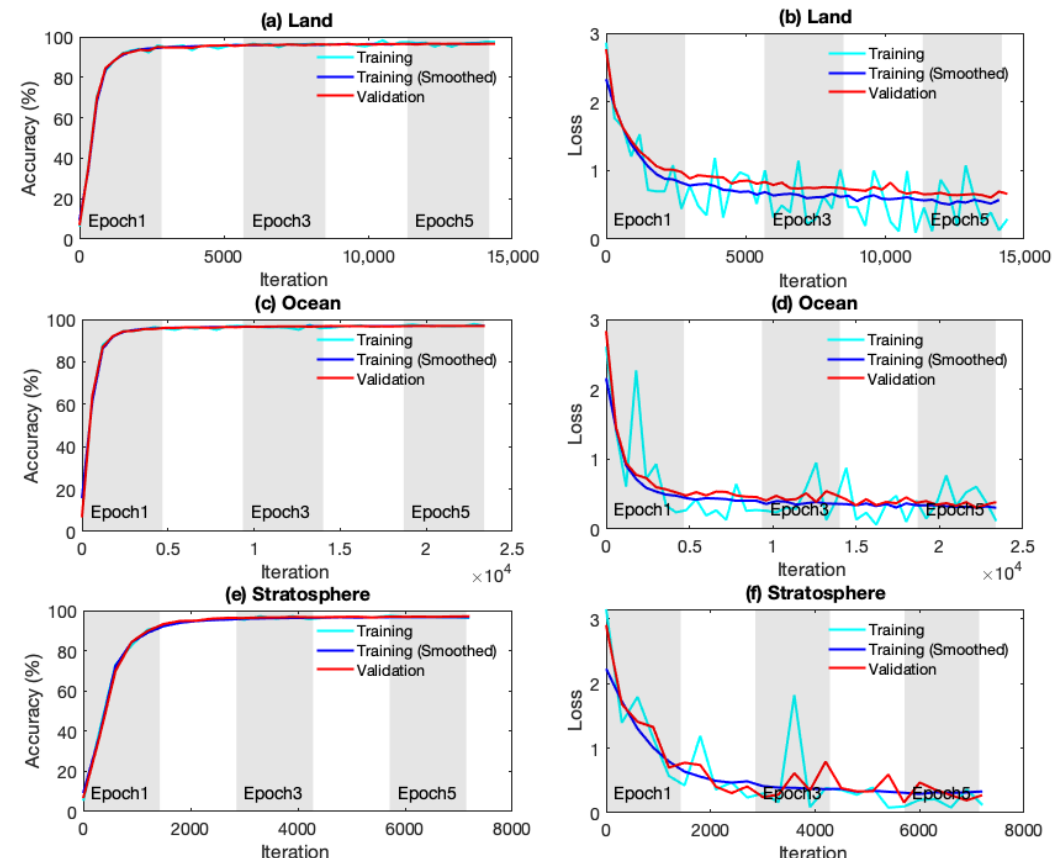
Figure 2. Training (cyan/blue) and validation (red) accuracy (left column) and loss (right column) against iteration or epoch over tropospheric land ( a , b ), tropospheric ocean ( c , d ), and in the stratosphere ( e , f ).